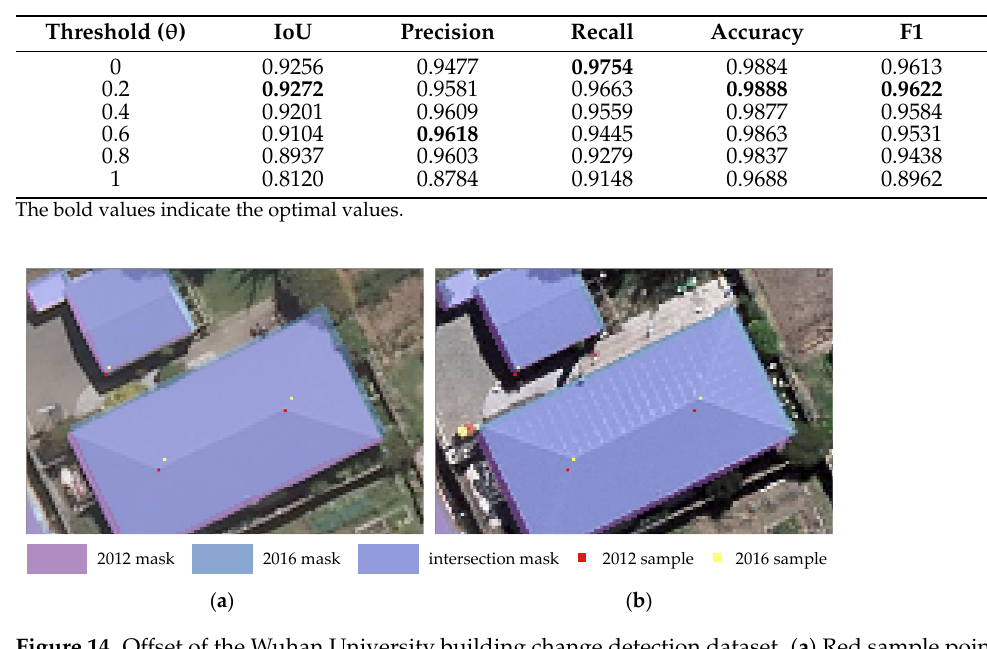
Table 7. Update results obtained by post-processing update strategies with different thresholds on the Beijing Huairou district land survey dataset.